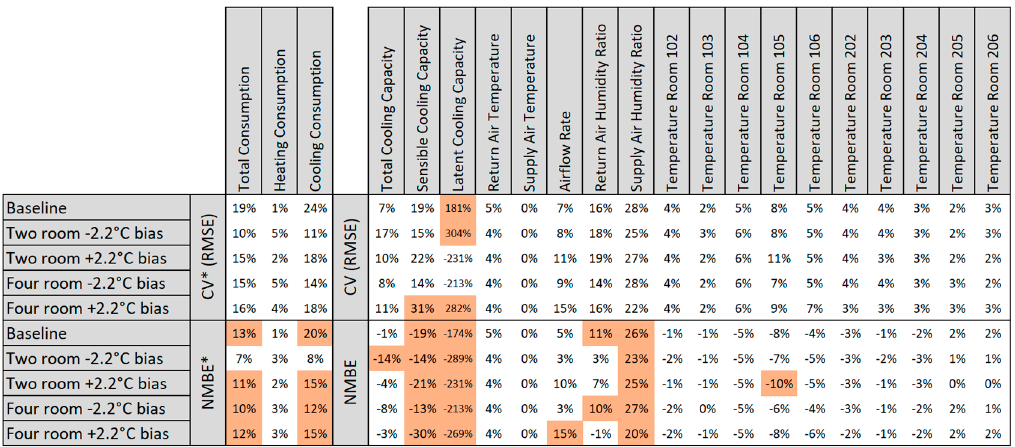
Table 8. CV (RMSE) and NMBE calculations for detailed model outputs: Thermostat measurement bias.